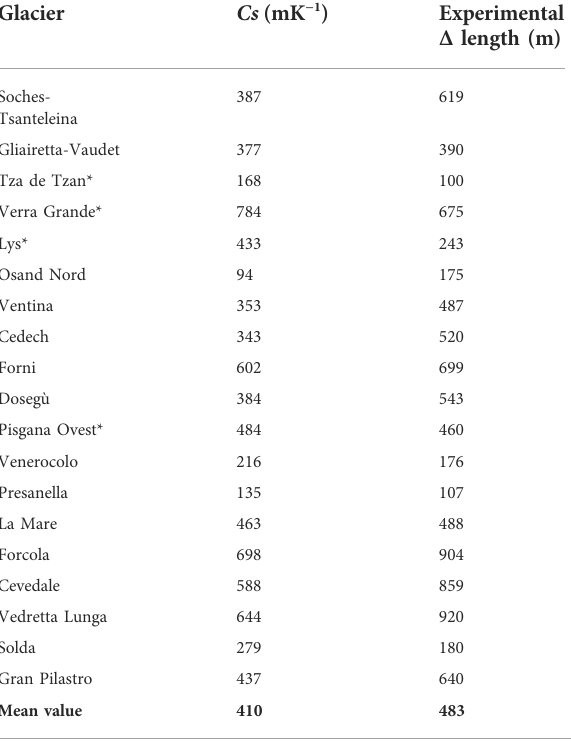
TABLE 2 Climate sensitivity ( C s ) and experimental Δ length between 1980 and 2017 of the measured glaciers. Glacier Cs (mK − 1